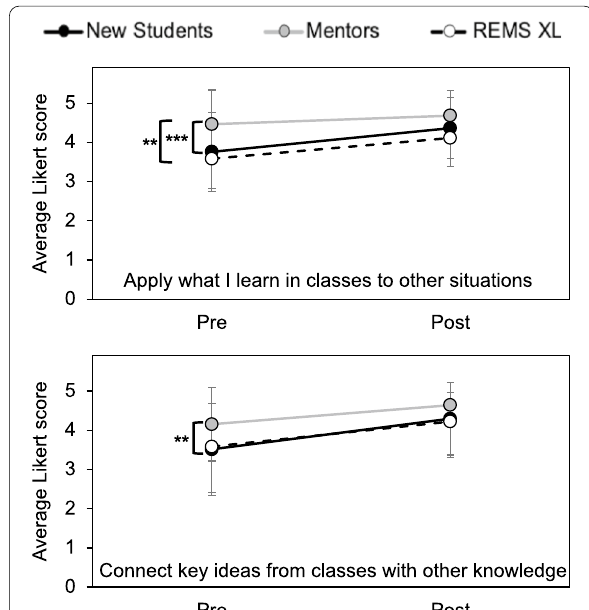
Fig. 21 Recognition: Comparing self-efficacy beyond the classroom among student groups. Average student responses (New Students ( N 105), Mentors ( N 26), REMS XL (12)) to REMS survey items = = (1 Not at all, 5 A great deal) regarding how well they integrate = = knowledge across disciplines or beyond the classroom. Differences among student group scores were analyzed with Kruskal–Wallis tests with post hoc Dunn’s tests. ** p < 0.01. *** p <